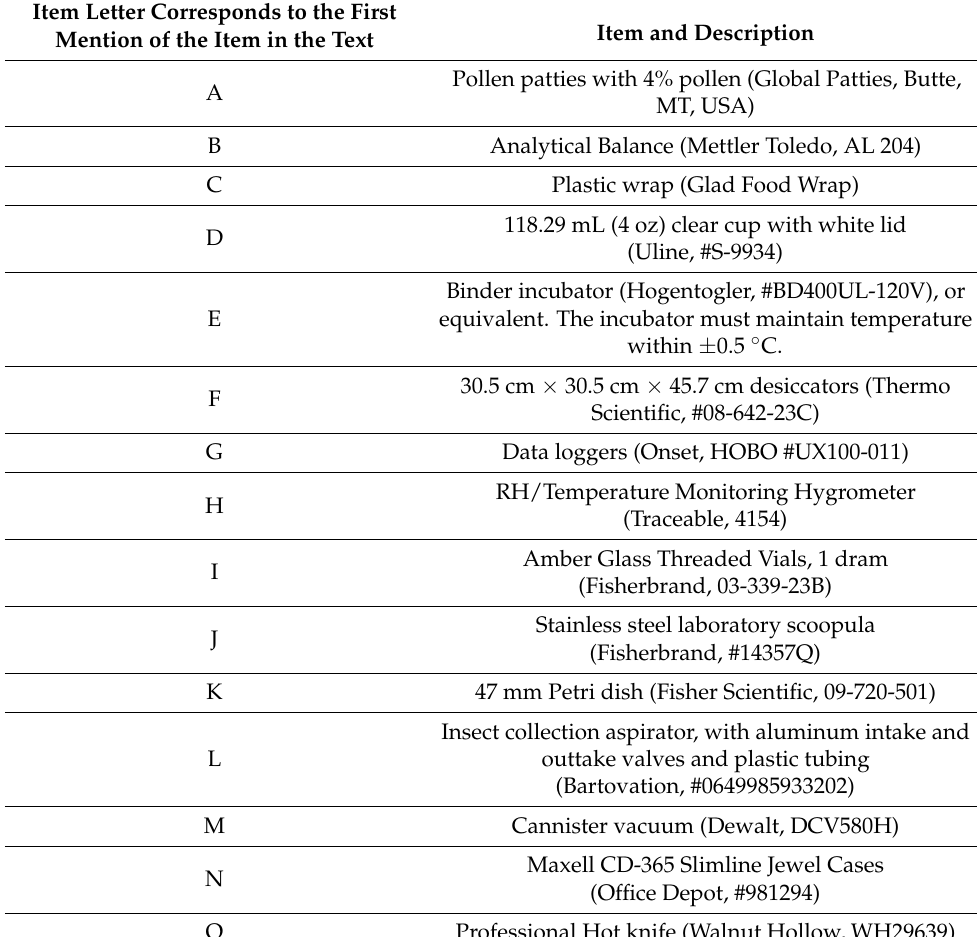
Table 1. Tools and supplies used for the acute toxicity laboratory bioassay and field